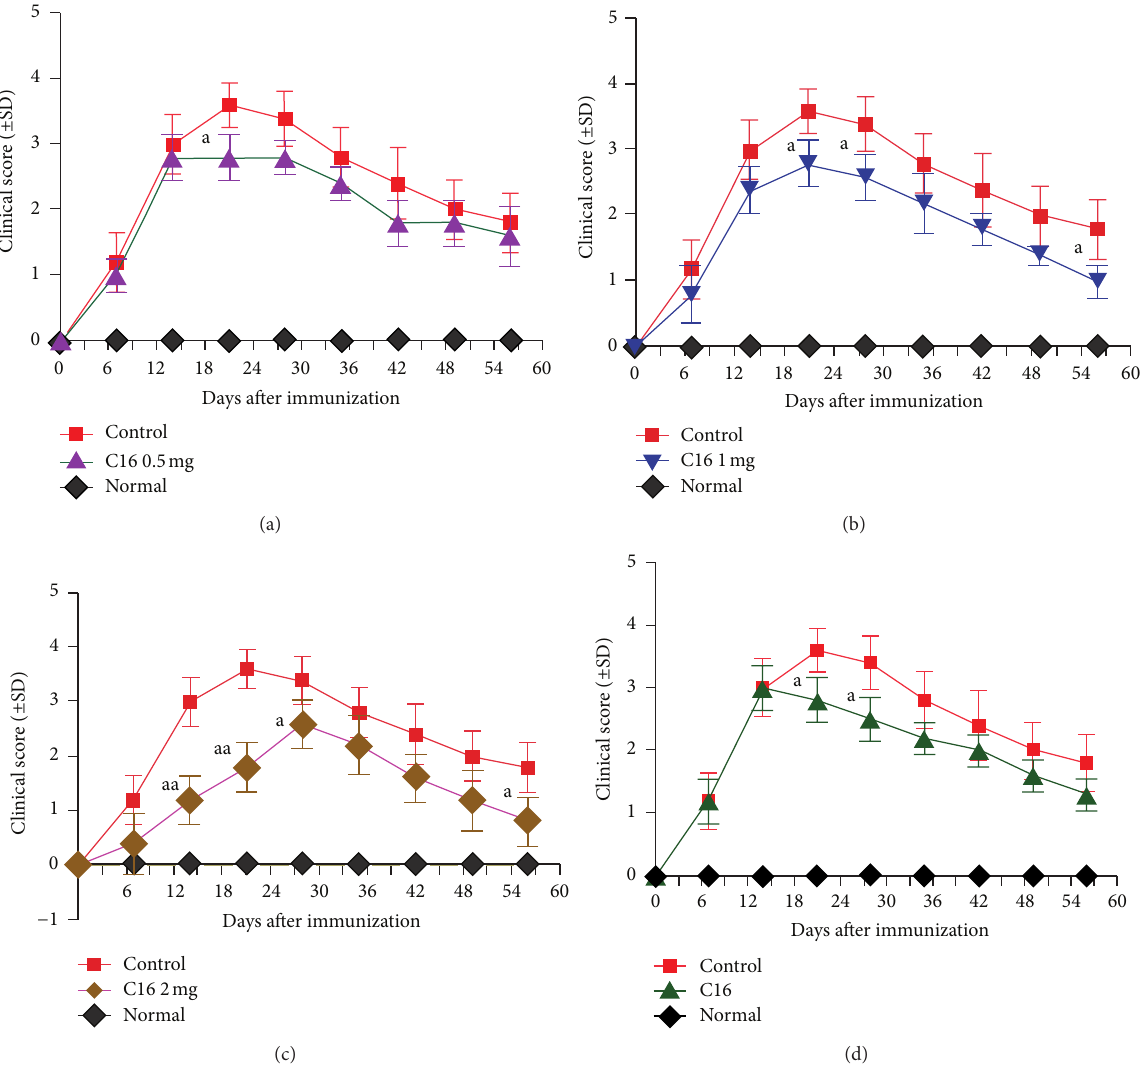
Figure 7: C16 treatment ameliorated the disease progression and alleviated the disease severity. ((a)–(c)) The clinical progression of EAE was attenuated after medium (b) and high (c) dose C16 applications. a 𝑃 < 0.05 versus vehicle treated group at the same time point. aa 𝑃 < 0.01 versus vehicle treated group at the same time point. (d) The clinical progression of EAE was attenuated by the C16 late treatment. a 𝑃 < 0.05 versus vehicle treated group at the same time